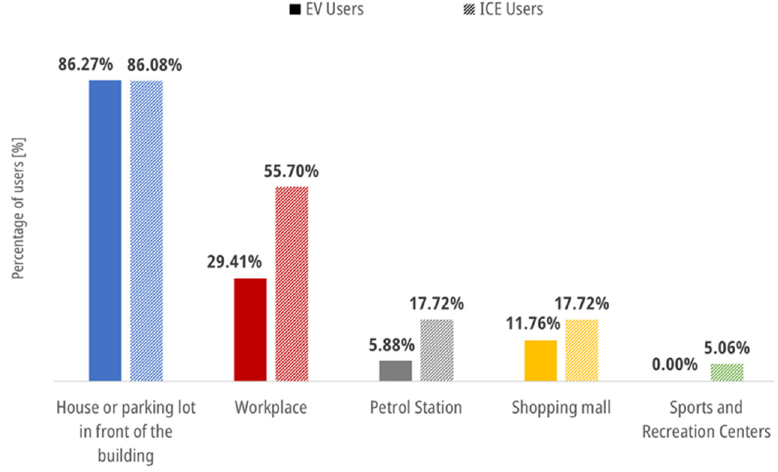
Figure A5. Responses to questions (8) and (9) expressed as a percentage of responders.